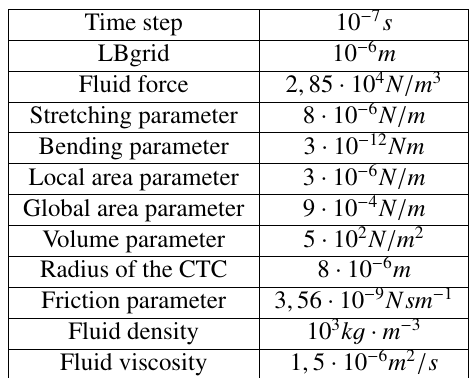
Table 6. Simulation